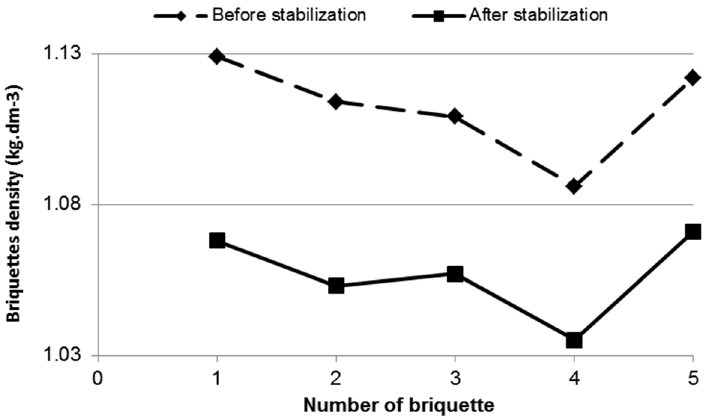
Figure 8. Briquette density values at 254 MPa compression pressure ( w r = 8%; L = 2